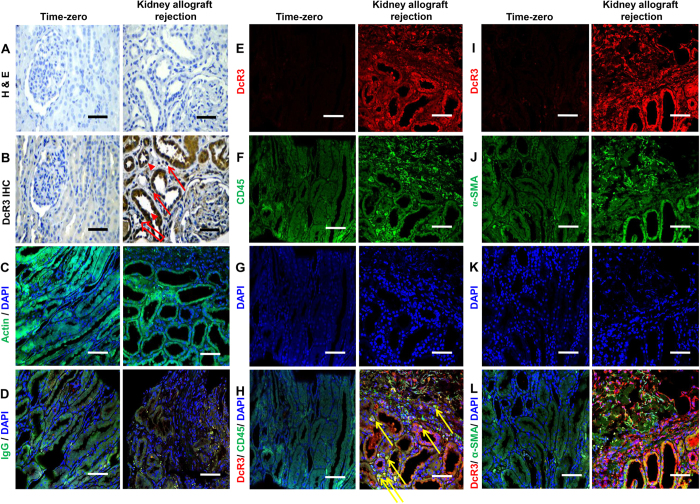
Representative photographs of immunohistochemical (IHC) staining and immunofluorescence (IF) double staining between severe kidney allograft rejection and time-zero biopsies.About IHC, the samples were immunolabeled with mouse anti-hDcR3, visualized using anti-mouse horseradish peroxidase (HRP) and mounted in high-sensitivity diaminobenzidine (DAB) chromogenic substrate. (A) Negative controls showed no immunostaining of decoy receptor 3 (DcR3). (B) Representative images show that DcR3 was not expressed in time-zero biopsies of kidney tissue of positive control subjects. In mixed-type acute rejection, acute T cell-mediated rejection was composed of Banff Type IIA [i-Banff: 2 (red arrow), t-score: 2 (red arrowhead), v-score: 1)]; in acute antibody-mediated rejection, type II [peritubular capillaritis (red hollow arrow)] showed strong DcR3 expression in RTECs. About IF double staining, the second antibodies (anti-rabbit IgG-FITC with green fluorescence and anti-mouse IgG-PE with red fluorescence) is for immunoreactivity. (C) Monoclonal anti-β-Actin antibody as internal control is for confirming technique in immunofluorescence staining. (D) The isotype antibody IgG is for negative control in the double immunofluorescence staining. (E) High DcR3 expression (HDE) was observed in the renal tubules and infiltrating mononuclear leukocytes in severe kidney rejection allograft. (F,J) CD45 and α-smooth muscle actin (α-SMA) were presented with green fluorescence in leukocyte cell membrane and interstitial myofobroblasts, respectively. (G,K) 4′-6-Diamidino-2-phenylindole (DAPI) is for nucleus. (H) There is colocalization between DcR3 and CD45 in severe kidney rejection allograft (yellow arrow). (I) HDE was obvious in the atrophic tubules of kidney rejection allograft. (L) No colocalization between DcR3 and α-SMA. Scale bar, 50 μm.